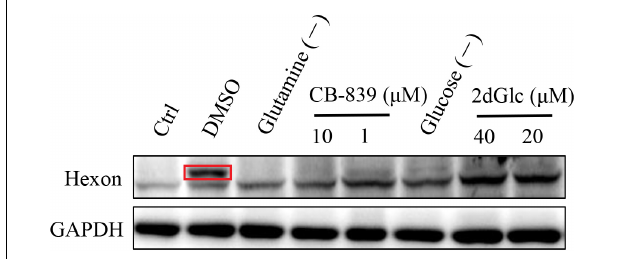
FIGURE 8 | Western blot analysis hexon expression in LMH cells by affecting glucose and glutamine metabolism. The destination strip is marked in the red box, and the below bands are